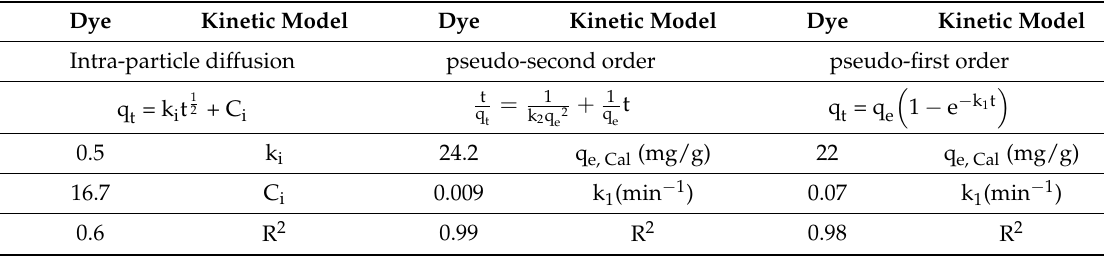
Table 2. Kinetic models for RR198 adsorption on activated Carbon/CoFe 2 O 4 (AC/CFO).